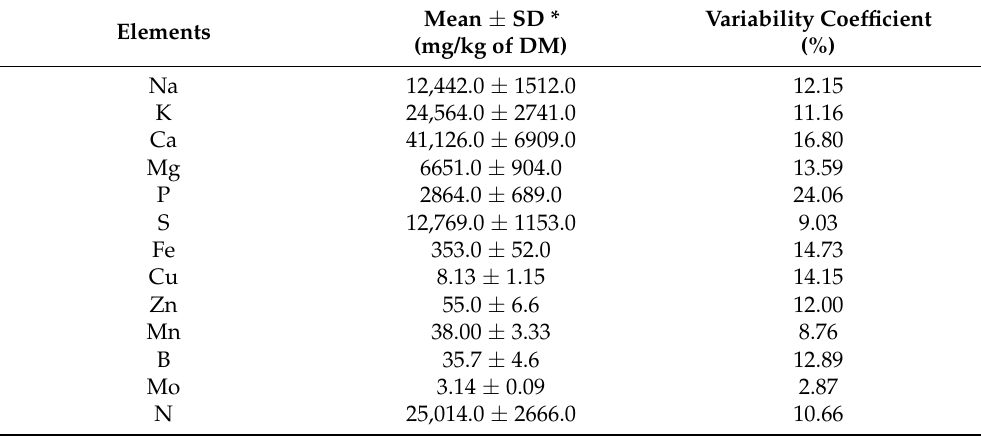
Table 2. Values of mean and standard deviations and coefficients of variation of chemical